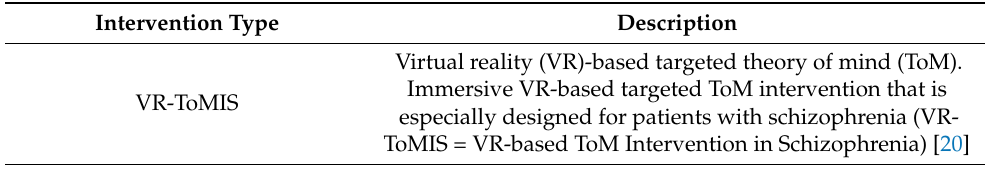
Table 2. Classification of intervention